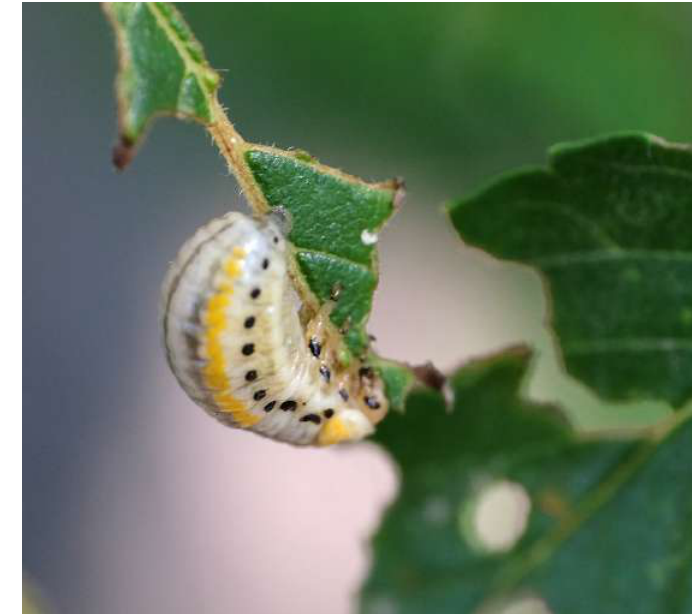
Figure 5. Larva of Ambrostoma superbum on a leaf of Ulmus pumila .